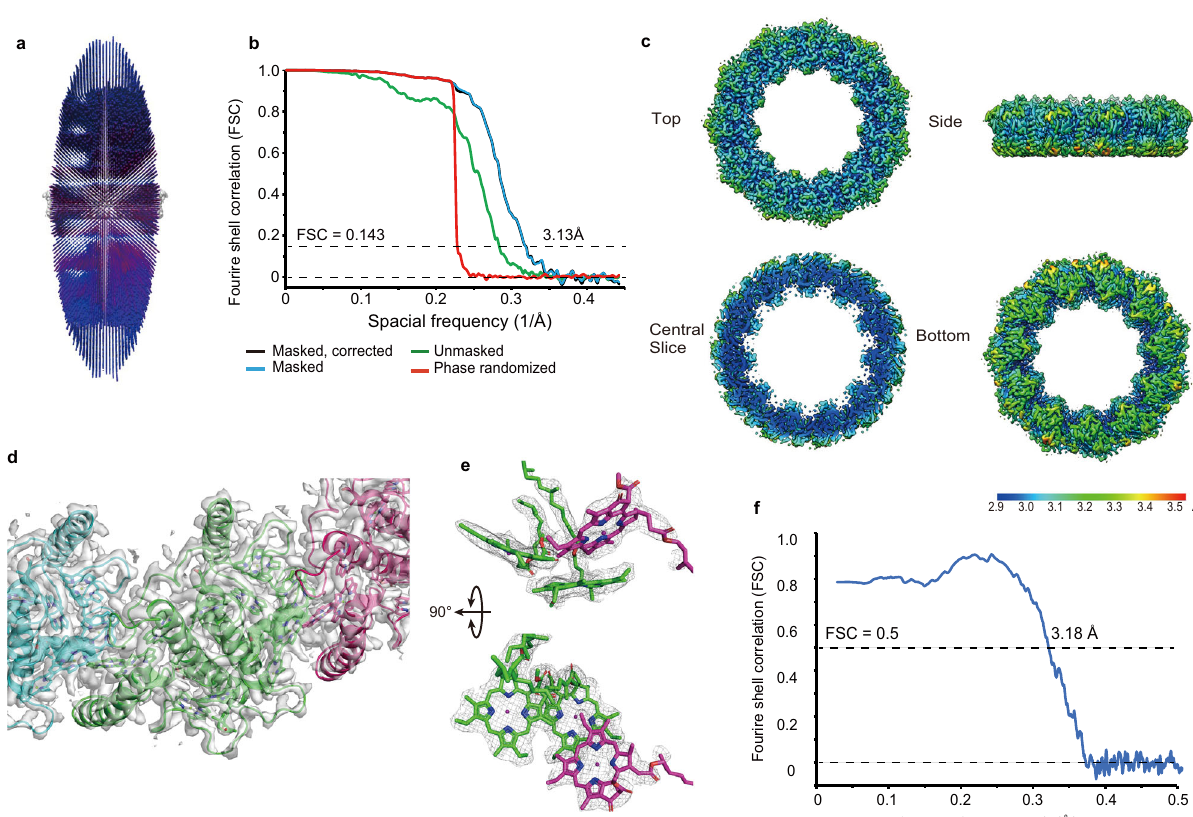
Fig. 4 | Summary of Cryo-EM analysis. a Angular distribution of the cryo-EM particles. b Gold standard Fourier shell correlation (FSC) curves of the re fi ned 3D reconstruction. c The 3D reconstruction is colored according to the local